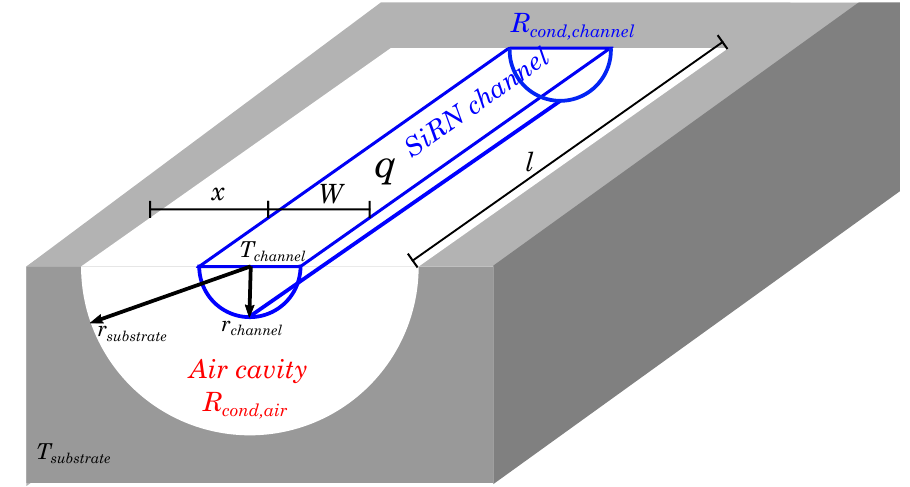
Figure 13. A simplified heat conduction model using a semi-circular air cavity underneath a suspended semi-circular